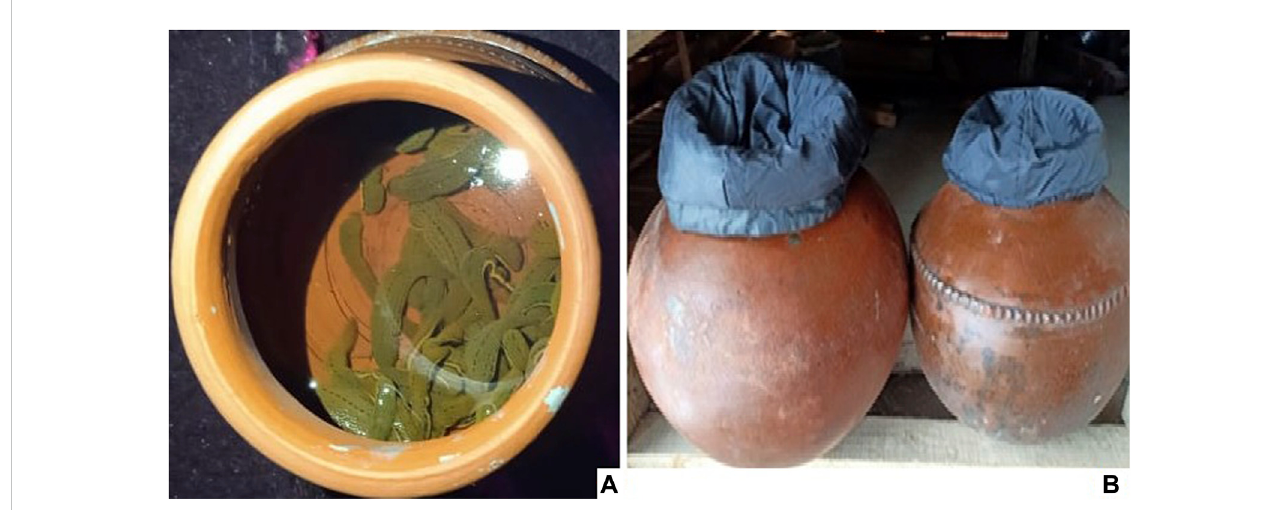
FIGURE 7 (A) Hirudinaria medicinalis (B) Traditionally pot used to keep medicinal leeches in J&K,